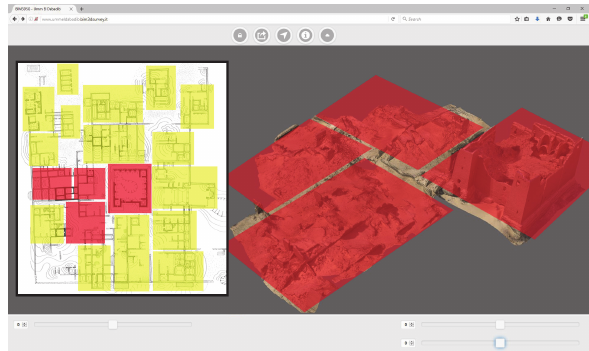
Figure 9. The image shows simultaneously 4 of the 18 buildings in BIM3DSG system.